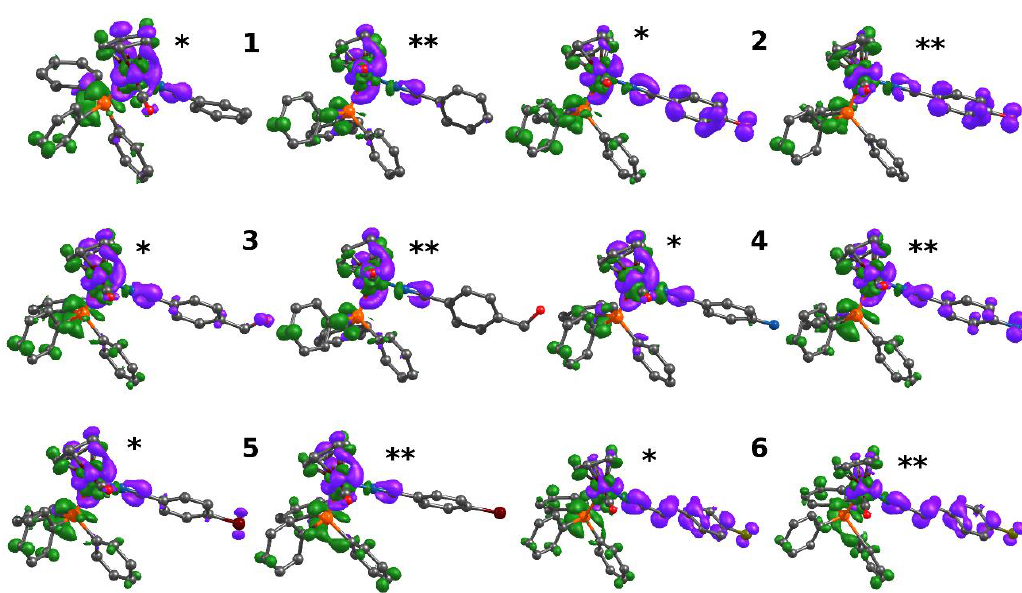
Figure 7. Electron density difference maps (EDDM) for complexes 1 – 6 for excitations presented in Table S2 and highlighted in Figure 6 with * and **. Violet and green correspond to a decrease and increase of electron density, respectively.